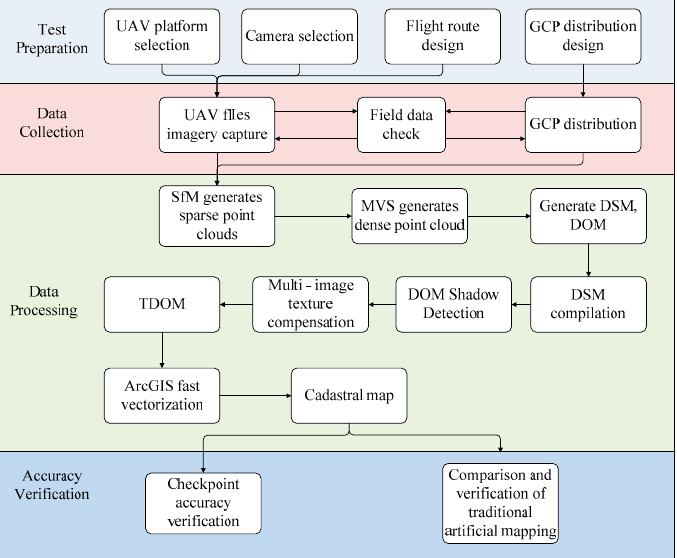
Figure 1. Workflow schematic of the study.